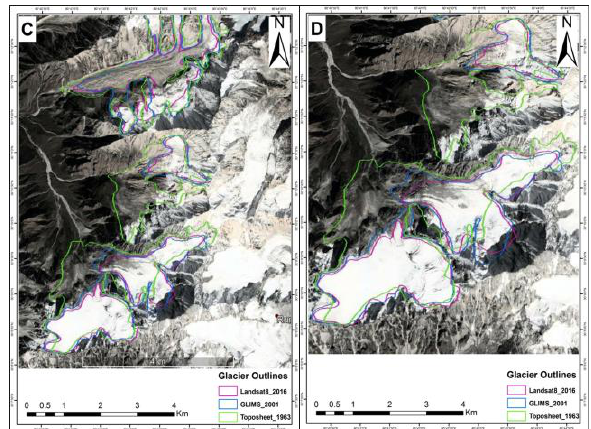
Figure 3 & 4. Loss in glacier area shown from different images: (A) SOI toposheets surveyed in 1963, (B) Landsat 8 OLI image, 06 Nov. 2016, (C) Google Earth image (13/10/2017), (D) High resolution Google Earth image, (13/10/2017).